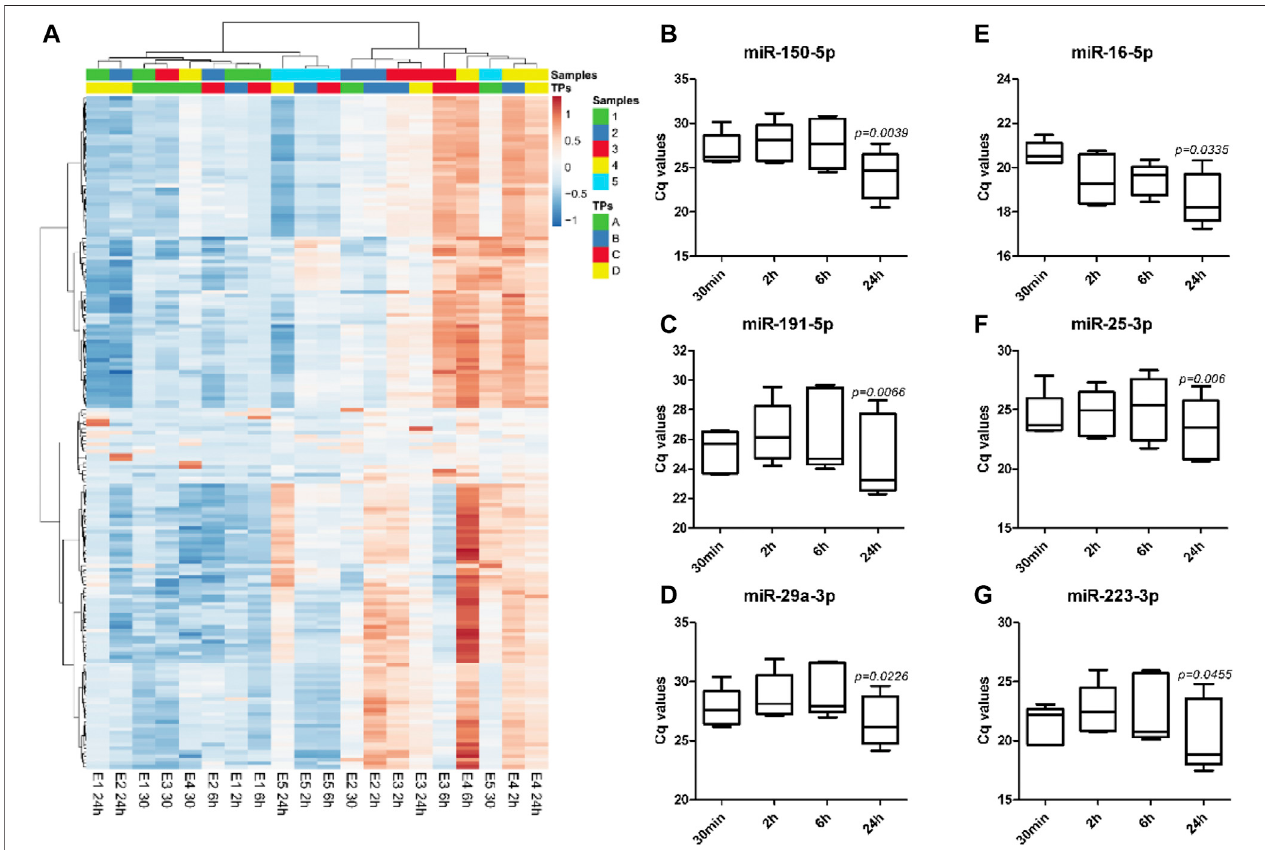
FIGURE 3 | The direction and the extent of changes in miRNA expression pro fi les with increasing holding time is sample-dependent. Unsupervised hierarchical clustering analysis shows expression pro fi les of 179 plasma miRNAs in EDTA samples with different holding times (TPs), A: 30 min, B: 2 h, C: 6 h, and D: 24 h (A) . HeatmapwasbuiltbasedonCqvaluesfromRT-qPCRusingPearsoncorrelationandWardlinkage.Signi fi cantchangesintheexpressionofspeci fi cmiRNAsassociated with preterm birth, miR-150-5p (B) , small-for-gestational-age births, miR-191-5p (C) , and preeclampsia, miR-29a-3p (D) , were observed with increasing holding time. Commonly used endogenous miRNA controls in plasma such as miR-16-5p (E) , miR-25-3p (F) , and miR-223-3p (G) , were also affected by blood holding